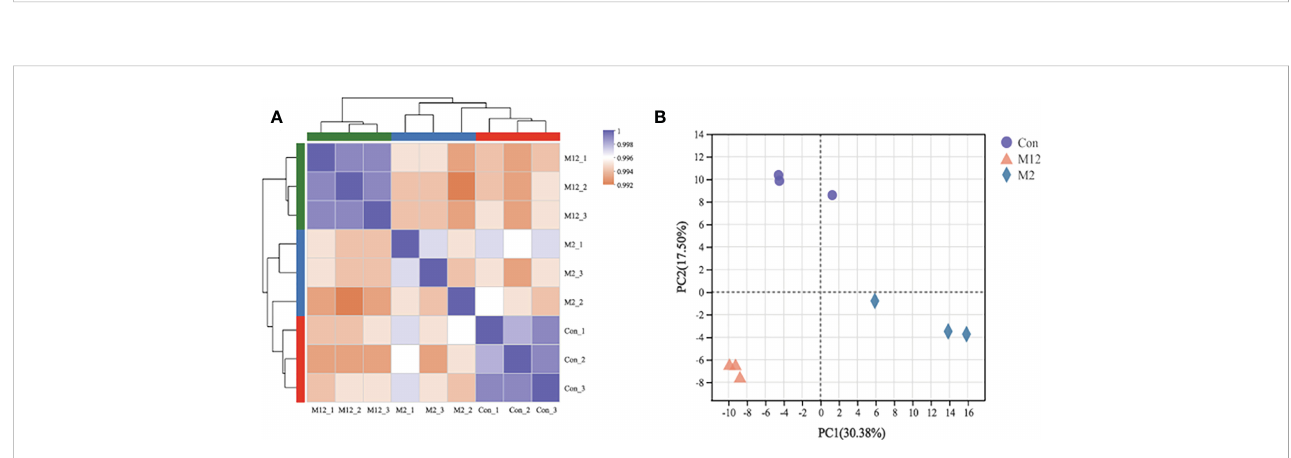
FIGURE 2 Relationships analysis between samples: Hierarchical clustering analysis (A) and principal component analysis (B) .